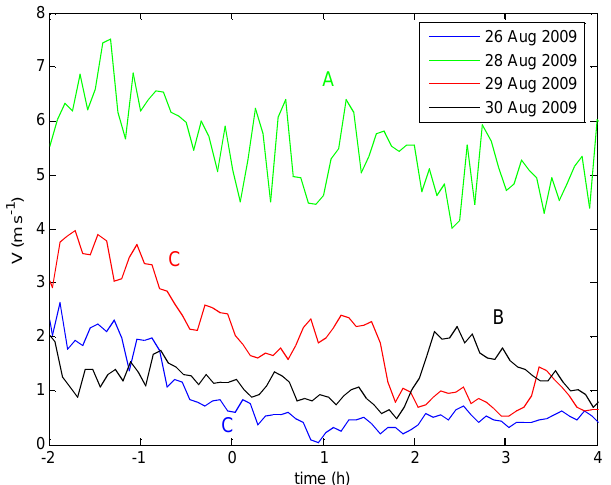
batic events (C). TKE values between 0.5 and 1.5 m 2 s −